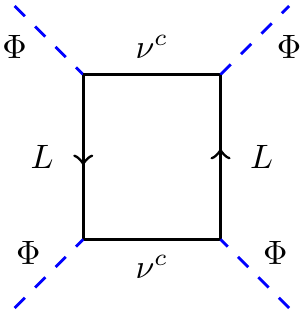
Figure 4 . The destabilizing effect of right-handed neutrinos on the evolution of the Higgs quartic